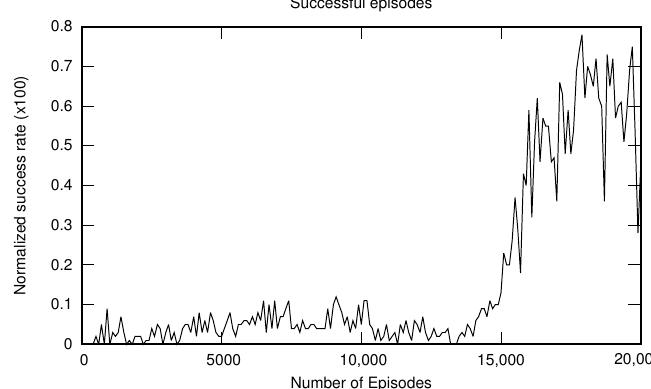
Figure 5. Learning curve for the last iteration of the schema.